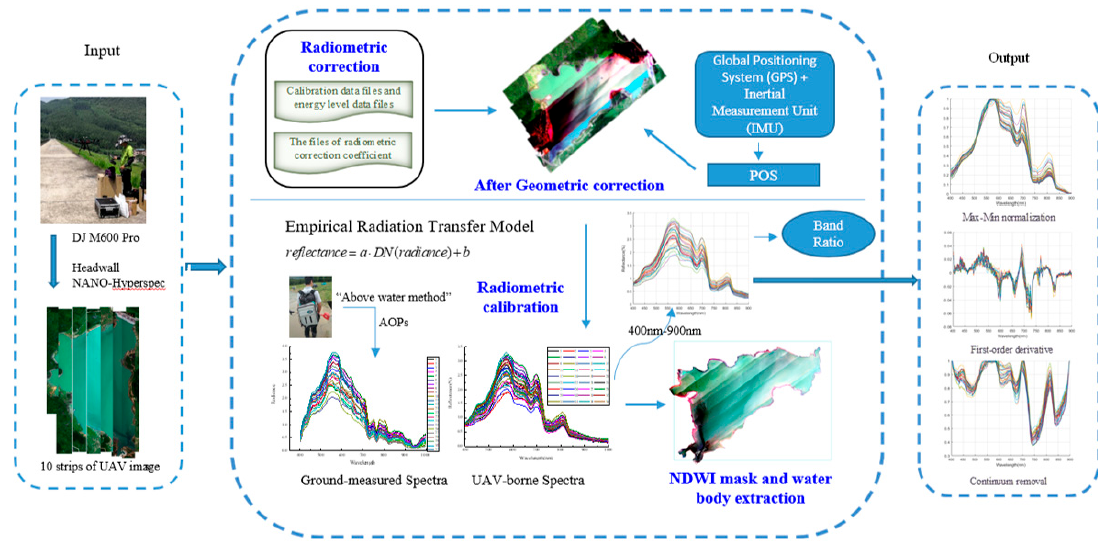
Figure 3. Preprocessing of the UAV-borne HRS images and extracted hyperspectral data.